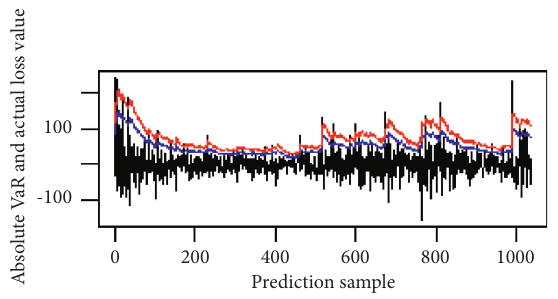
Figure 2: Comparison of absolute VaR value and actual loss based on RiskMetrics